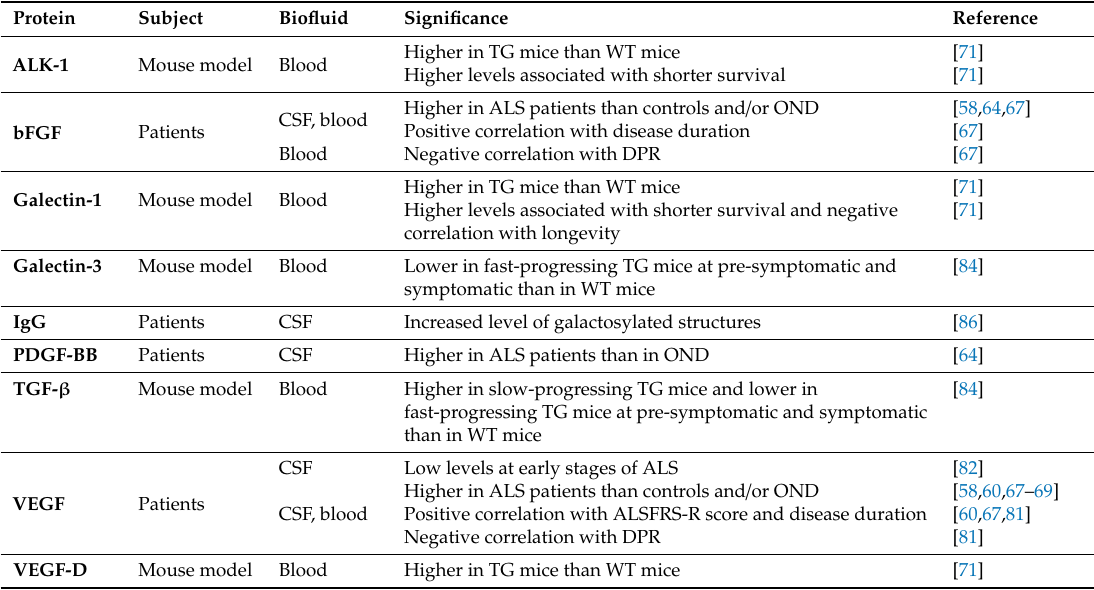
Table 6. Other cytokines and proteins related to inflammation found dysregulated and proposed as biomarkers in biofluids from ALS animal models and